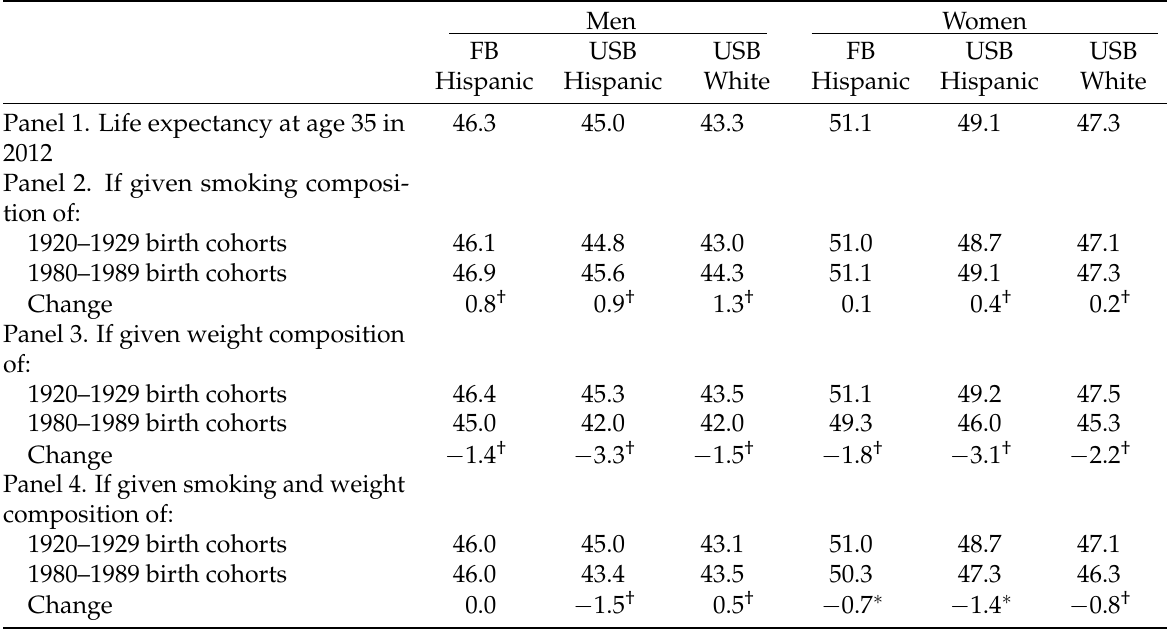
Table 3: Simulated change in life expectancy at age 35 due to cohort compositional change in smoking duration and weight status. Men FB USB USB FB USB USB Hispanic Hispanic White Hispanic Hispanic White Panel 1. Life expectancy at age 35 in 46.3 45.0 2012